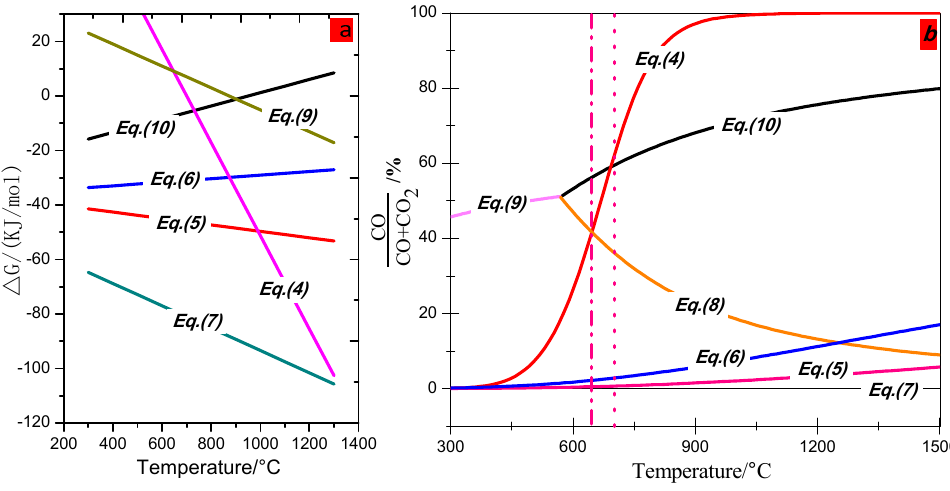
Figure 10. Thermodynamic analysis of reduction of metal oxides (( a ) The standard Gibbs free energy of reactions (4)–(10) on the different temperatures; ( b ) Restore balance of cobalt oxide, nickel oxide and iron oxides).